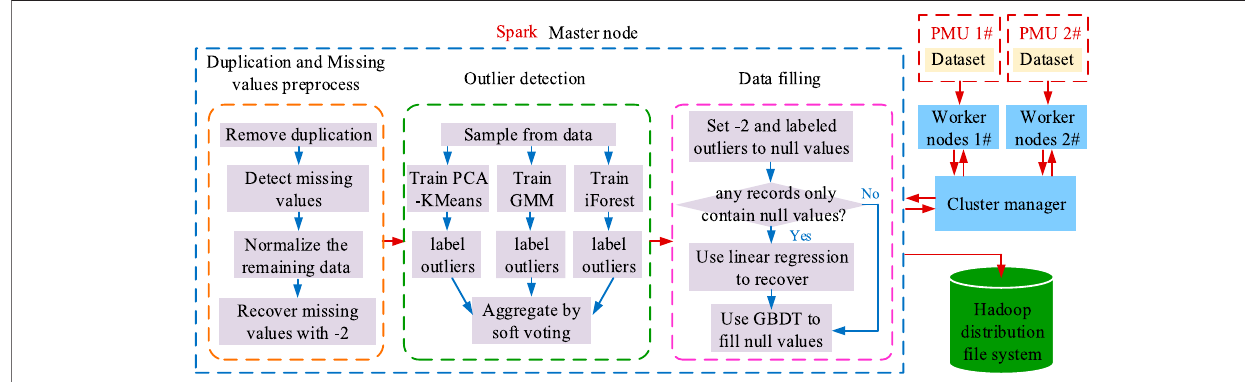
FIGURE 1 | The framework of data cleaning in Spark.